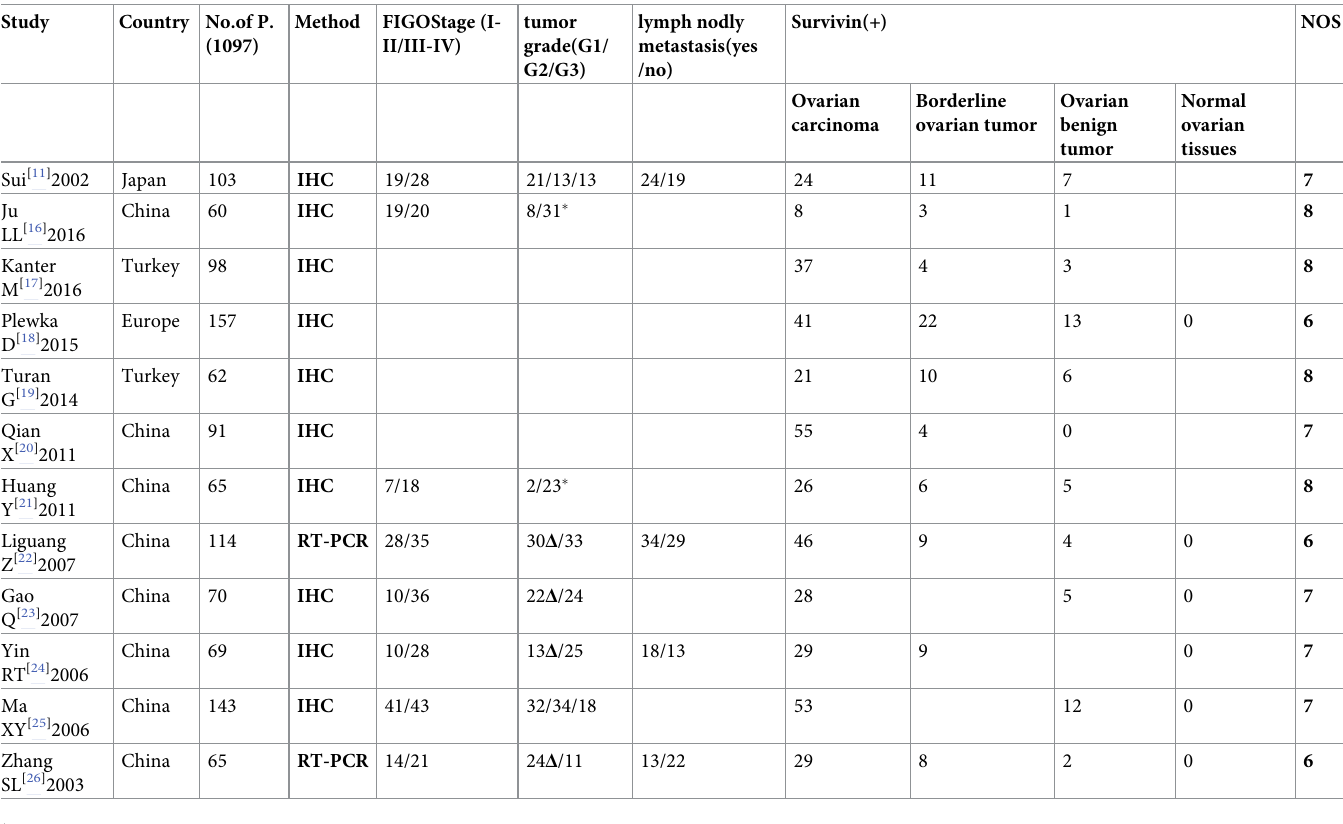
Table 1. Characteristics and results of the included